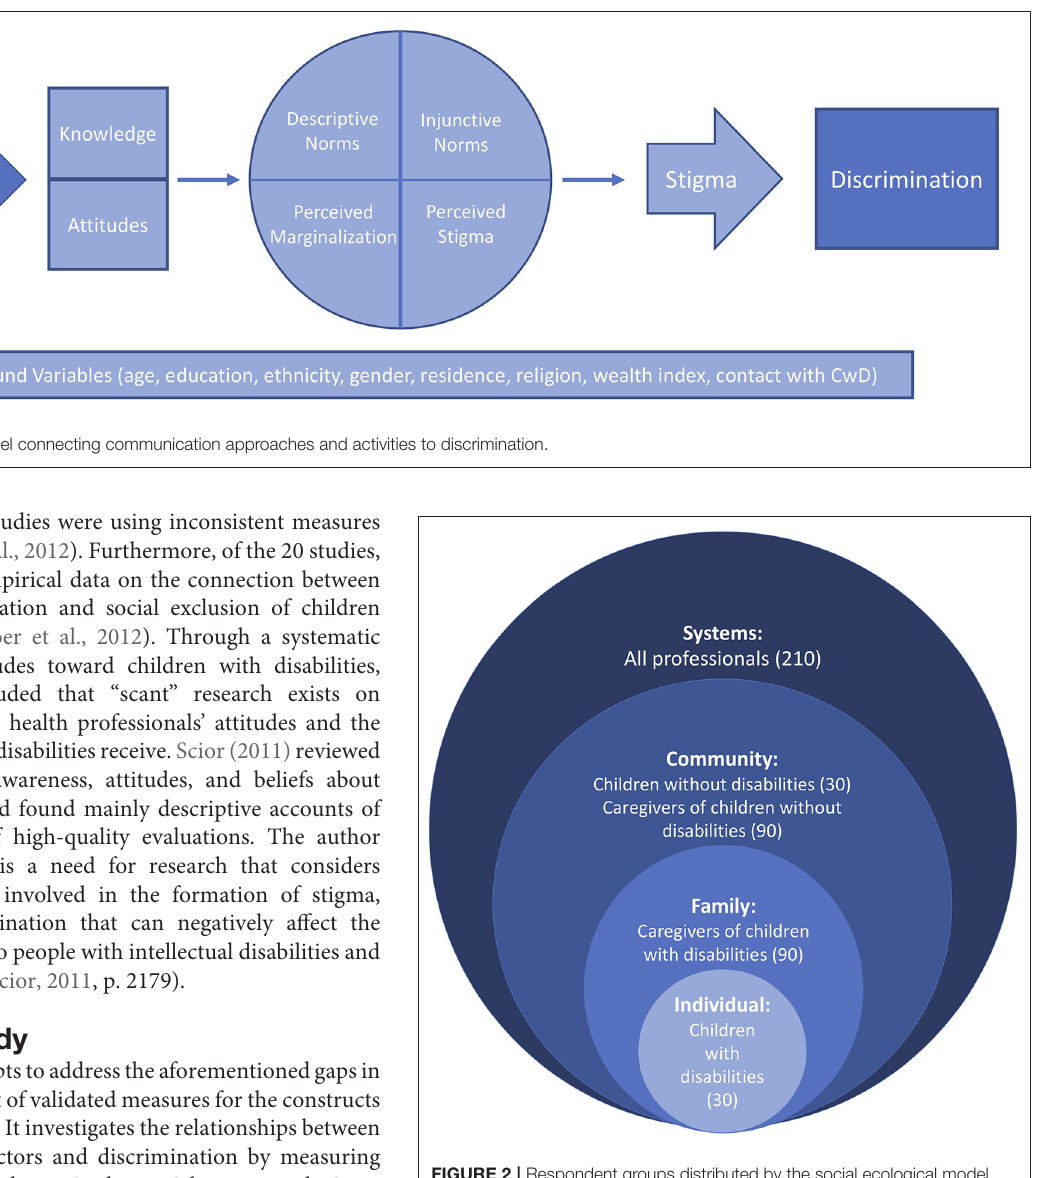
FIGURE 2 | Respondent groups distributed by the social ecological